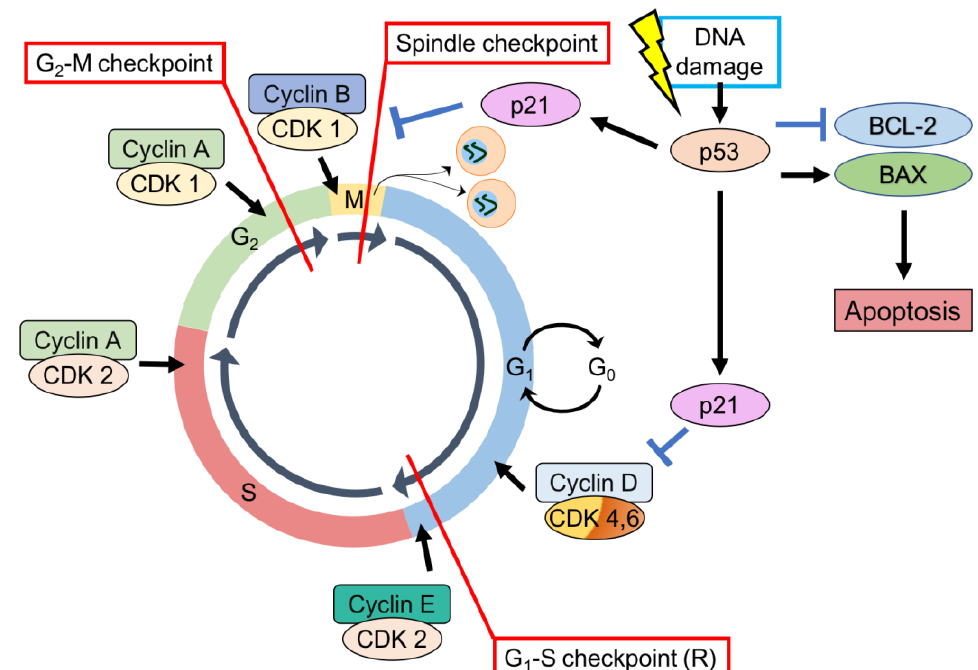
Figure 2. p53, CDK substrates, CDK inhibitors, and cyclins—regulation of the cell-cycle. (1) G1-S checkpoint. (2) G2-M checkpoint. (3) Spindle checkpoint. p53 can also stimulate intrinsic apoptotic signaling pathways through stimulation of BAX expression and inhibition of BCL-2 expression.